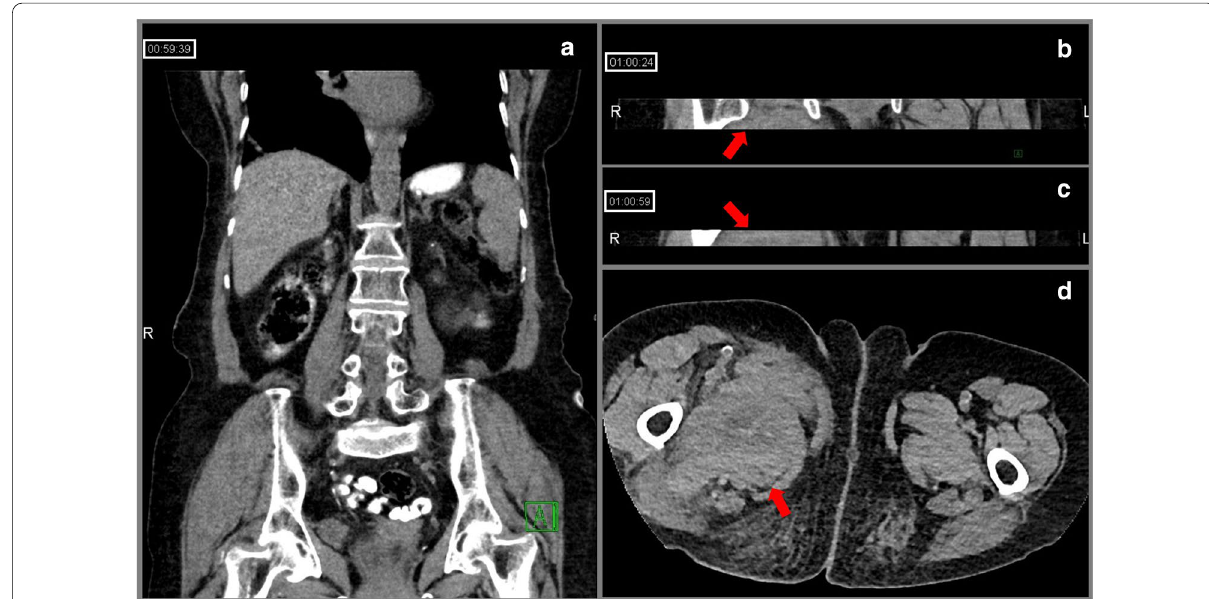
Fig. 9 Technique-related (Type 6) error with poor communication. An 88-year-old female patient using an injectable anticoagulant was admitted to the emergency room with right lower quadrant pain. No finding to explain the symptom was observed on abdominal CT ( a ). Right inguinal swelling developed during follow-up and inguinal US revealed a large hematoma in this region. When the abdominal CT was evaluated retrospectively, it was noticed that, apart from the sections examined by the on-duty radiologists, two more series consisting of only 10–15 axial slices showing inguinal regions were separately uploaded to the PACS together with their coronal reformats ( b , c ). It was later learned that the CT technician had difficulty adjusting the field of view and had to take a few extra slices to cover the level of the symphysis pubis. However, he did not inform the on-call radiologists about this situation. Since the images were sent to the PACS piece by piece due to a technical error, and the radiologists were not informed about the problem due to lack of communication, the diagnosis of a clearly seen right inguinal hematoma was delayed (red arrows, b , c , d )